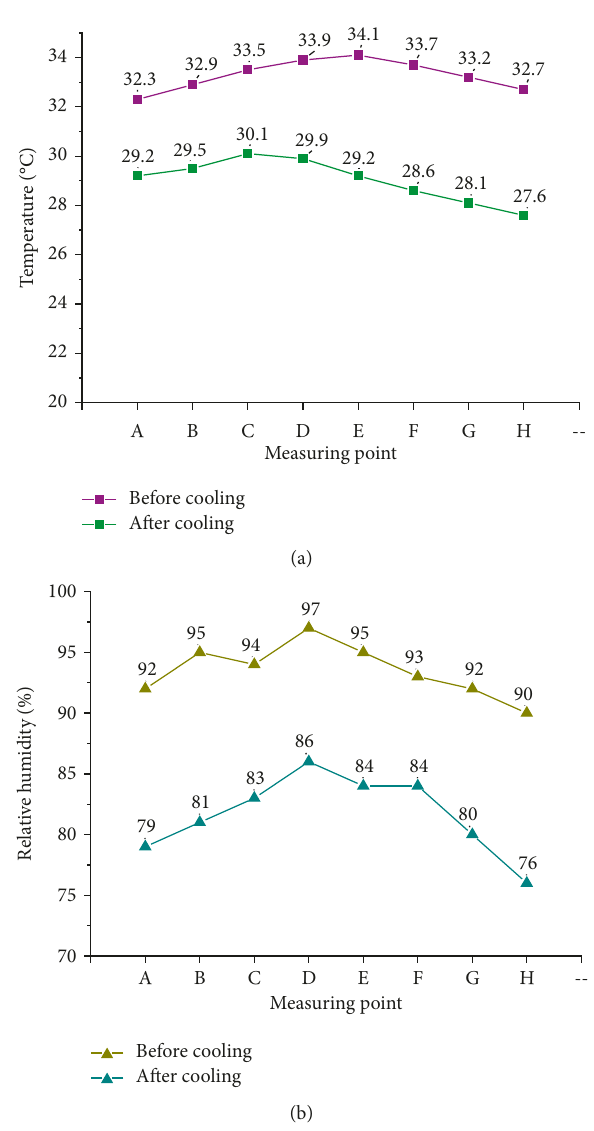
Figure 6: Comparison of temperature and humidity on the working face. (a) Before operation. (b) After